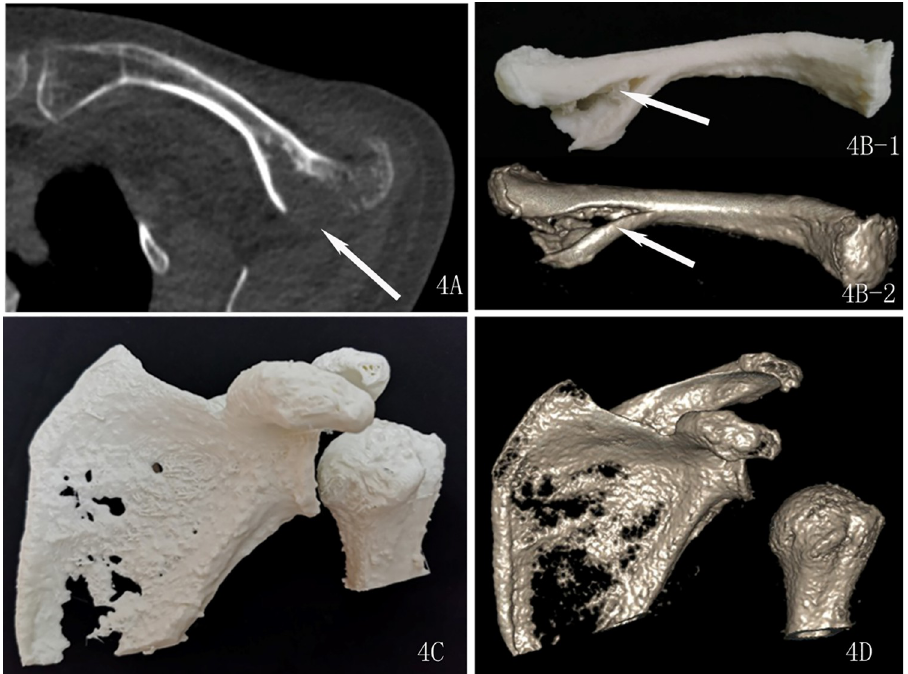
Fig 4. A 65-year-old female with a left clavicle comminuted fracture underwent an ultra-low-dose CT scan. 4A: axial image shows the fracture line (arrow), scored 2 points. 4B and 4D: Three-dimension reconstruction images of the clavicle show the fracture line (arrow). 4B: Three-dimension reconstruction images, scored 2 points. 4C: Three- dimension printed model of the scapula and humerus, scored 1